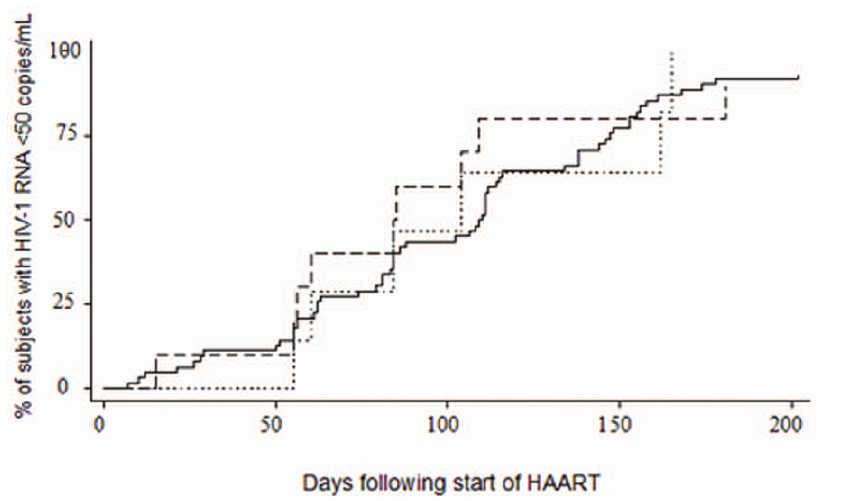
Figure 1. Time to suppression of plasma HIV-1 RNA levels among previously ARV-naı¨ve subjects with and without minority variant drug resistance mutations. Figure 1: The median time to virologic suppression (HIV-1 RNA , 50 copies/mL) was 110 (IQR 62–147) days for 63 treated subjects without detectable mutations (solid line), 84 (IQR 56–109) days for 10 subjects with minority variant mutations treated with $ 3 active ARVs (dashed line), and 104 (60–162) days for nine subjects with minority variant mutations treated with , 3 active ARVs (dotted line)